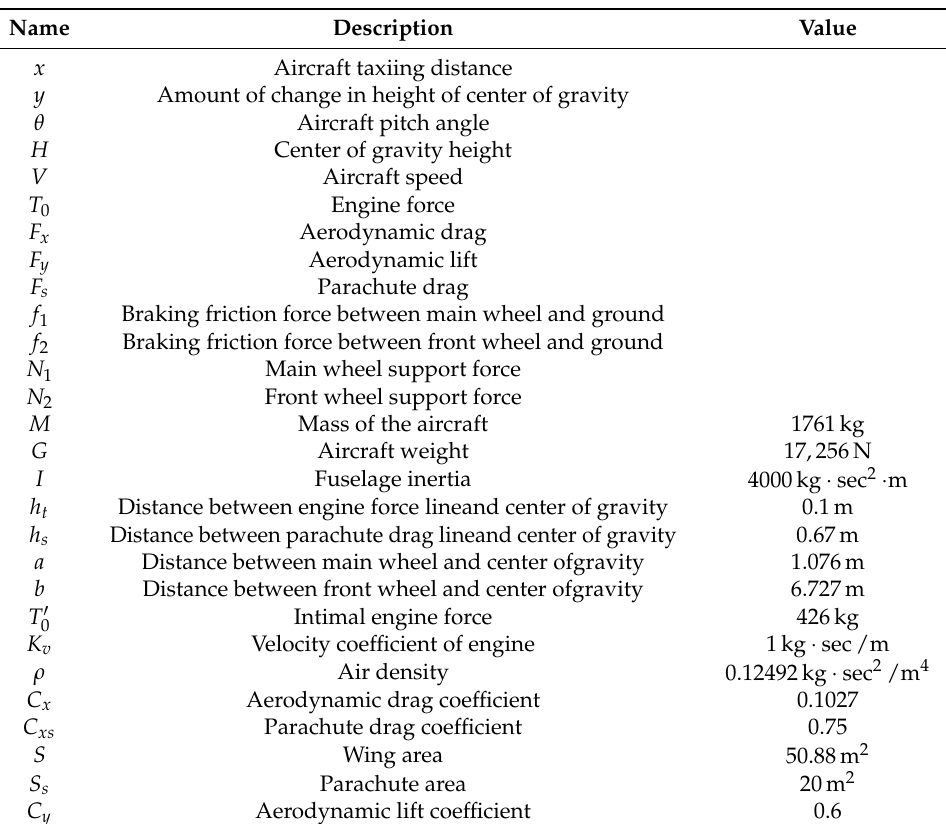
Figure 1. Force diagram of aircraft fuselage. Table 1. Parameters for aircraft fuselage dynamics.